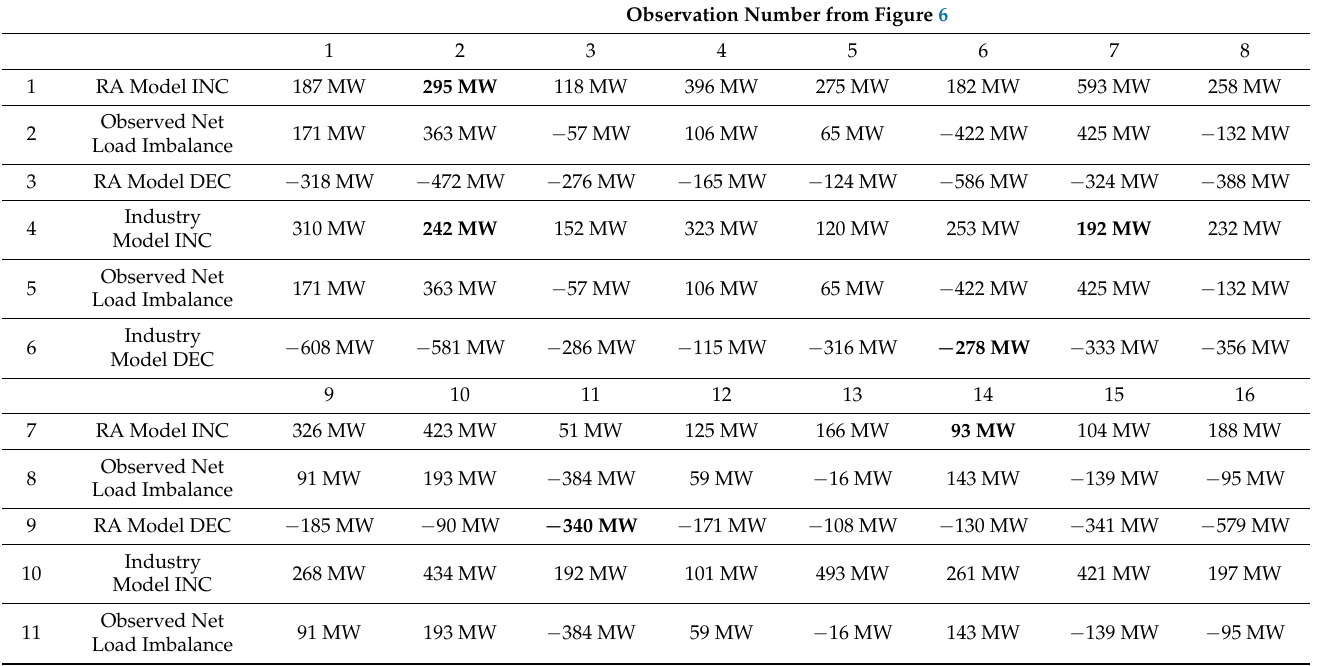
Table 11. Observed Net Load Imbalance and RA and Industry Model INC and DEC predictions for each interval from Figure 6.